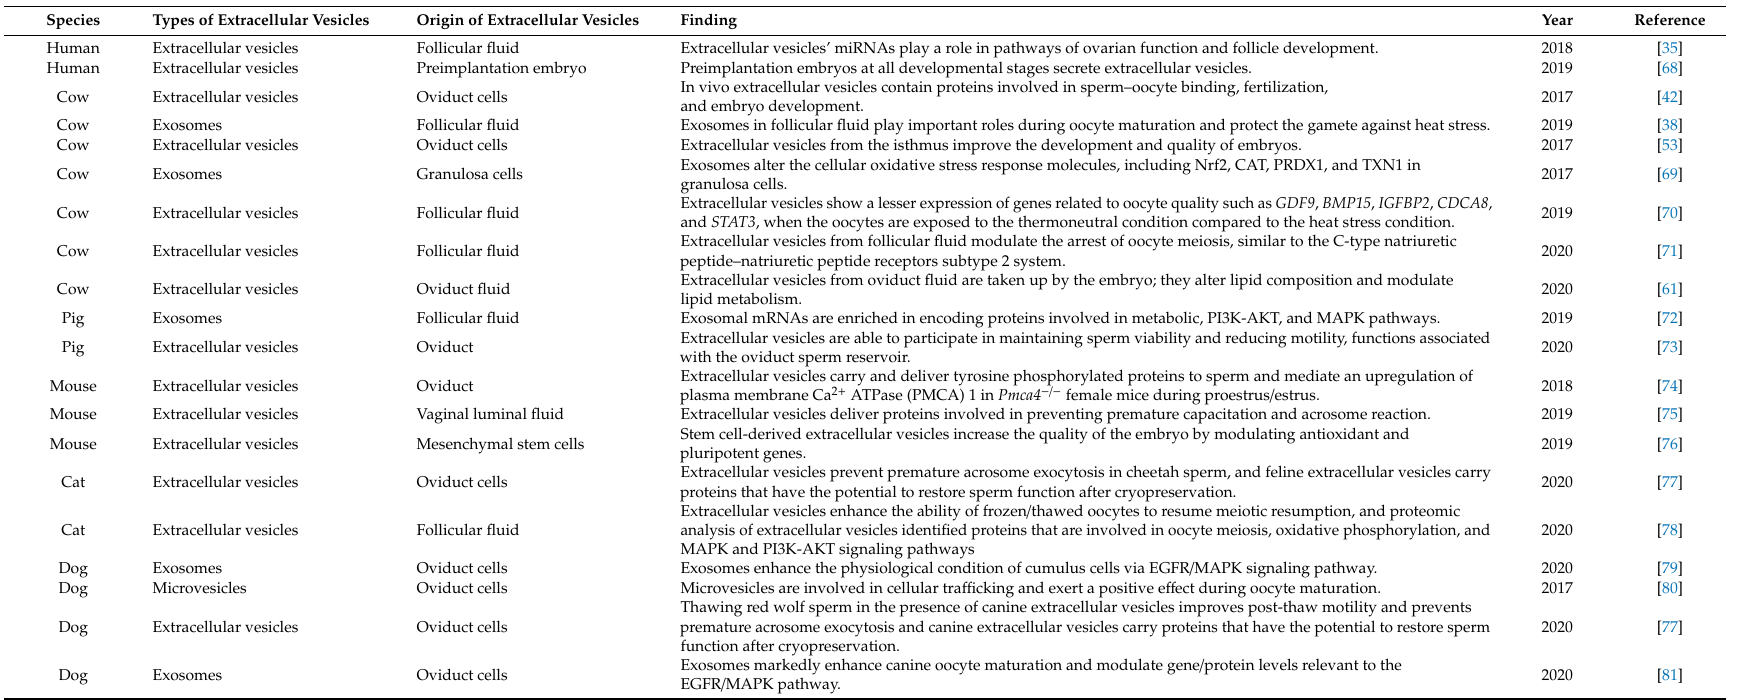
Table 1. Recent studies related with the e ff ect of extracellular vesicles on gametes / ovary / cumulus cells / embryos development. Species